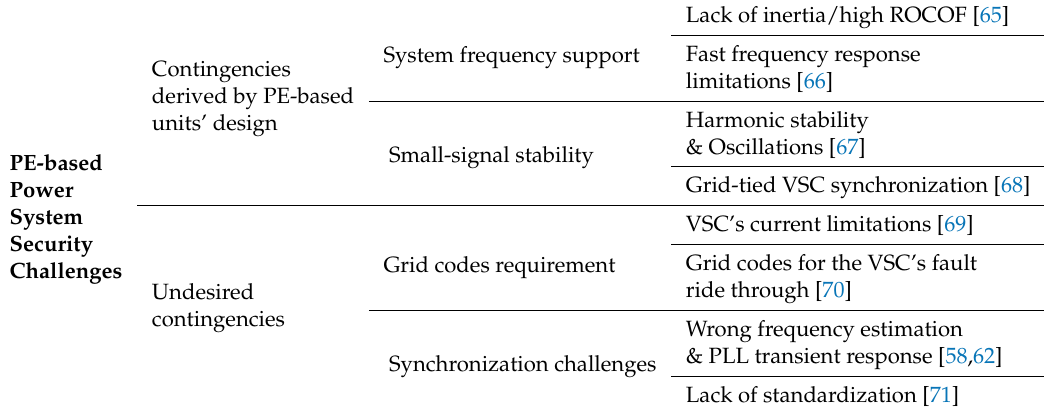
Table 2. PE-based power system security